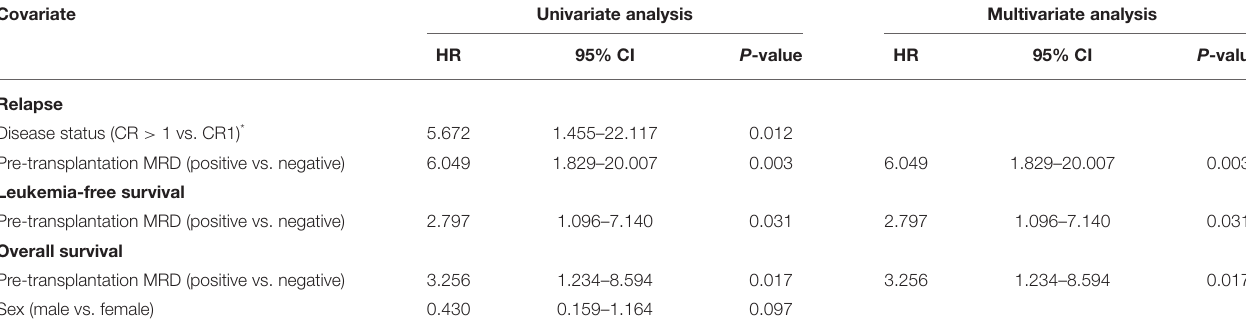
TABLE 4 | Multivariate analysis of factors associated with outcomes of patients with Ph positive ALL who underwent MSDT ( n = 61).